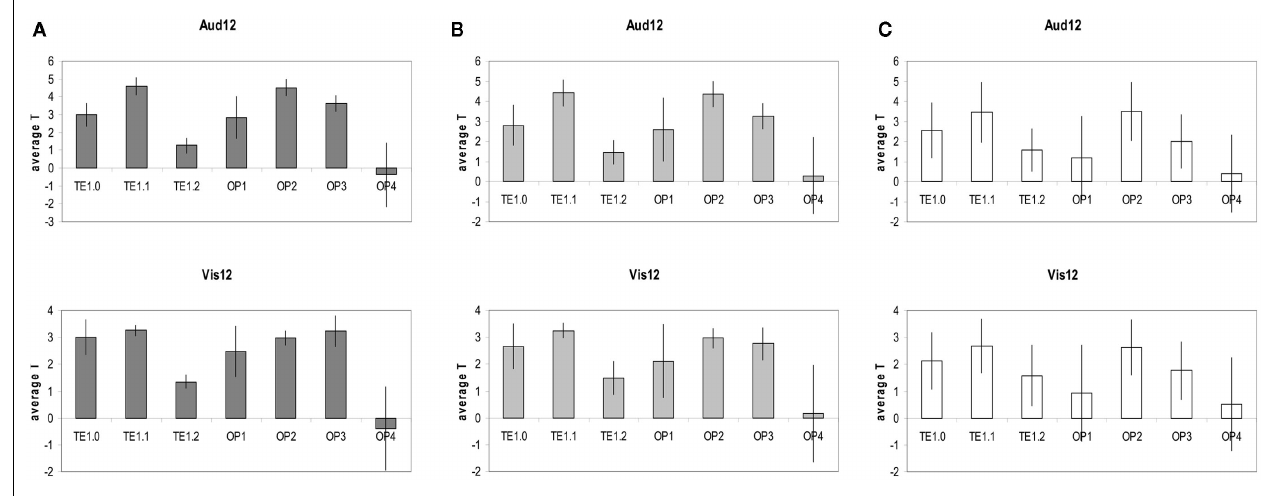
structural correlates of Aud12 andVis12 are robust withinTE1.1, OP2, and OP3 and are highly consistent and stable within these regions. Error bars, SD. (B) Same as (A) but over all the MNI coordinates that have a medium likelihood (probability of 40–60%) to be in the structures of A1/PAC and SII according to the Juelich atlas (see above). (C) Same as (A) but over all the MNI coordinates that have some likelihood (probability of 10–40%) of being in the structures of A1/PAC and SII according to the Juelich atlas (see